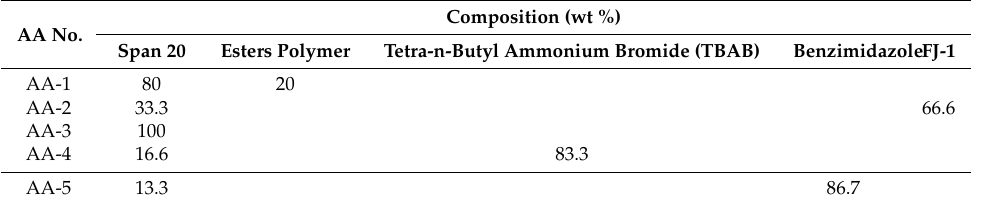
Table 5. Specification of tested AAs.